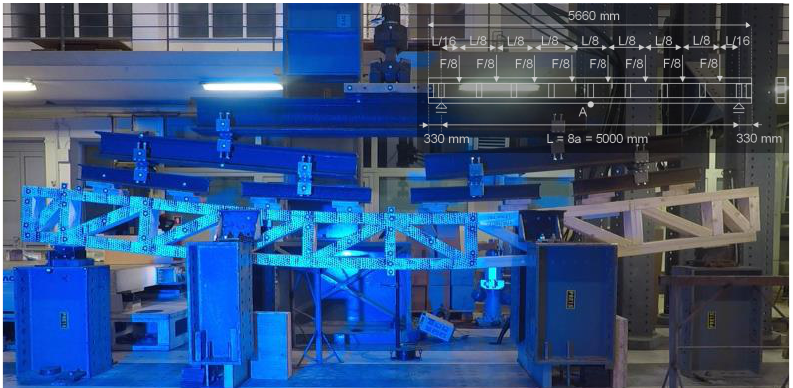
Figure 4. Test setup for bending tests of composite timber beams (variation 0.1-V1D; timber frame with compressive diagonals and no web